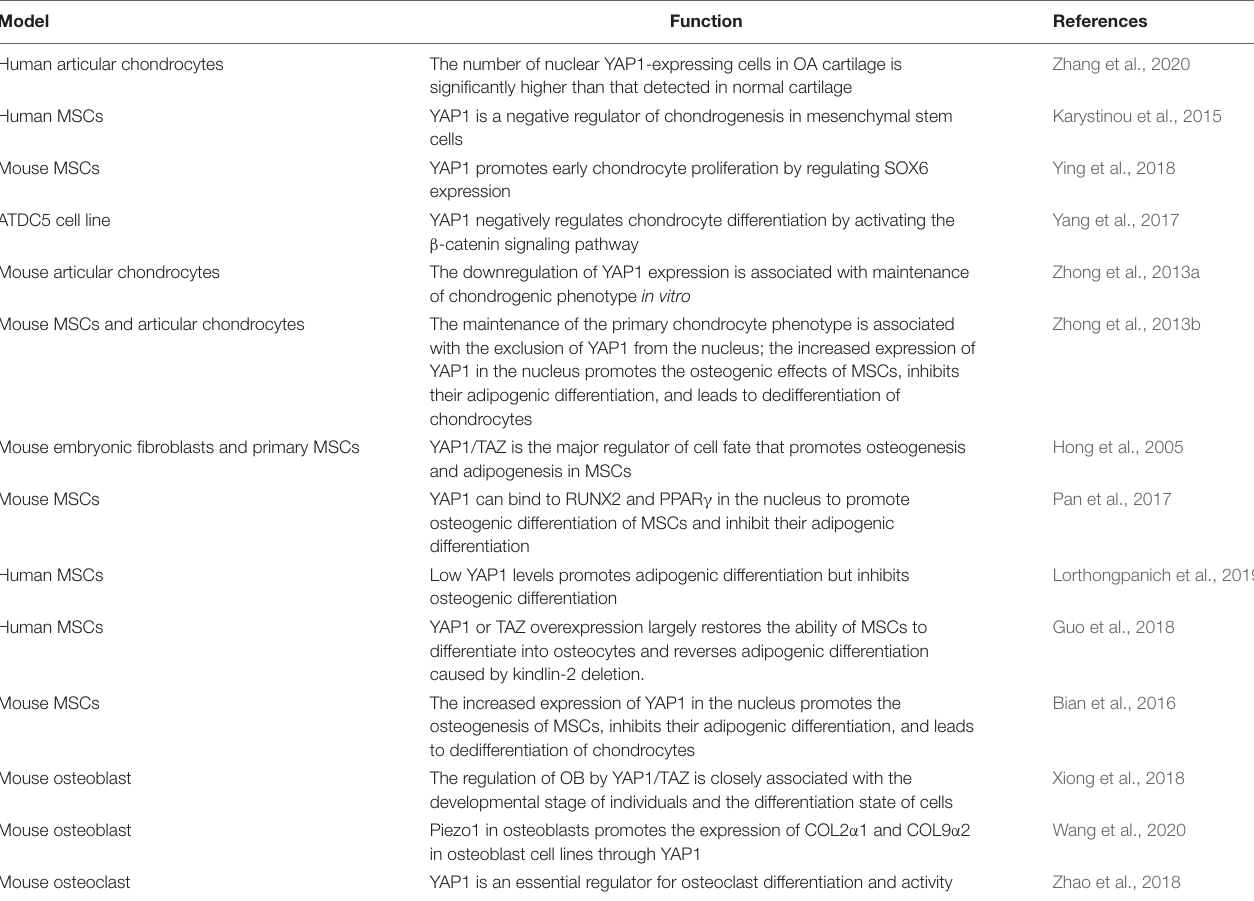
TABLE 1 | The role of YAP1 in different cell